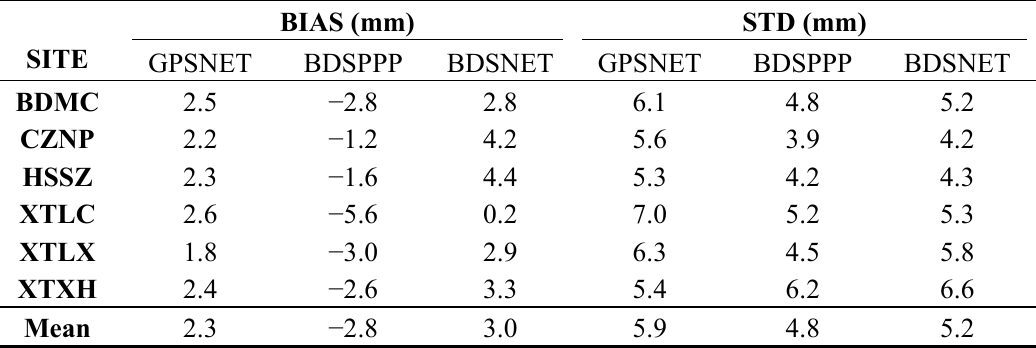
Table 2. Bias and STD of ZTD differences of GPSNET, BDSPPP and BDSNET with respect to that of